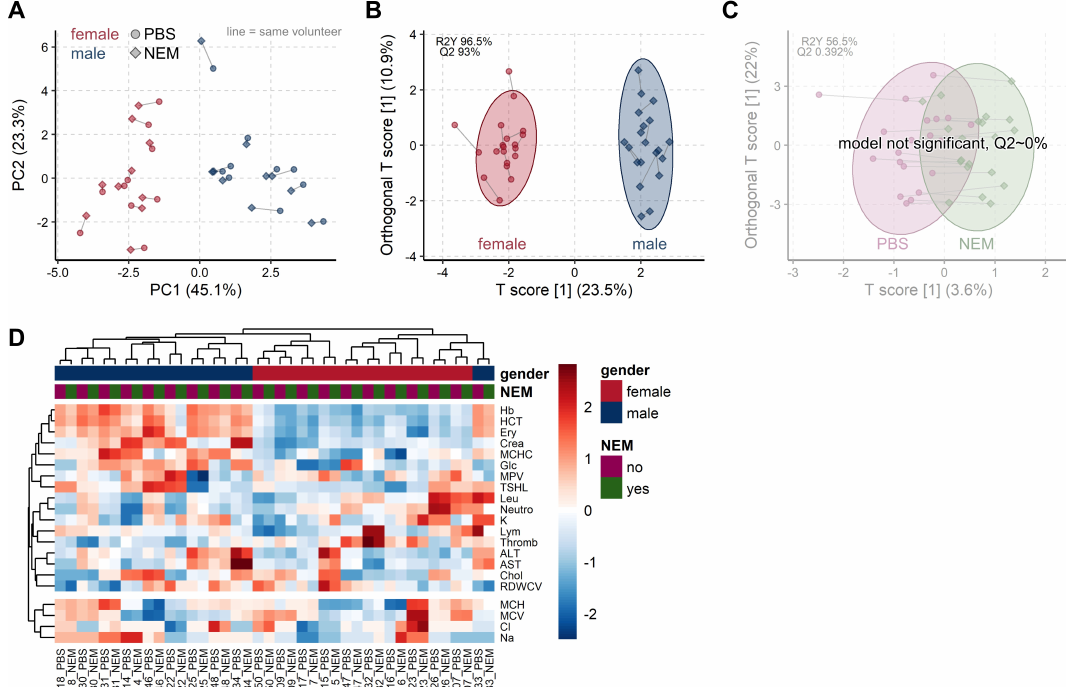
Figure 2. Addition of NEM to the blood tubes does not influence common clinical blood parameters. ( A ) The unsupervised PCA scores plot shows the very high similarity of all 21 clinical parameters for each of the 20 volunteers (connected by the gray line) when measured from tubes spiked with PBS (circles) or with NEM (diamonds). Samples are colored according to gender (female red, male blue), showing the expected strong group separation. ( B ) OPLS-DA scores plot reconfirm the PCA findings that clinical parameters significantly differ between gender, while ( C ) the addition of NEM to PBS has no significant impact (( A,C ) values in Supplementary Materials, Data 1). ( D ) Heatmaps with hierarchical clustering show the similarity of obtained values between tubes with PBS or NEM, always clustering both samples from the same volunteer